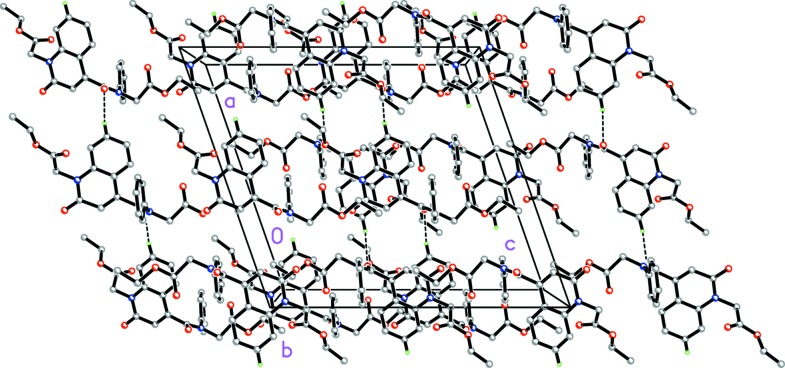
A partial packing diagram viewed along the b axis. Weak C—HOxqn⋯OEthx and C—HPh­yl⋯OCarbx (Oxqn = oxoquinolin, Ethx = eth­oxy, Phyl = phenyl and Carbx = carboxyl­ate) inter­molecular hydrogen bonds are shown as dashed lines. The disorder is not shown.